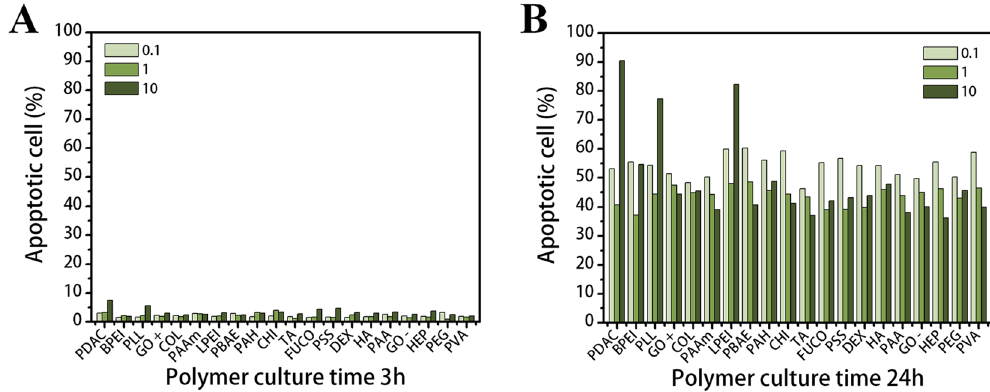
Figure 4. Cytotoxic effects of polymers on PBMCs. Apoptotic cell ratios of three polymer concentrations from 0.1 to 10 µ g/mL after ( A ) 3 h and ( B ) 24 h. Negative control is